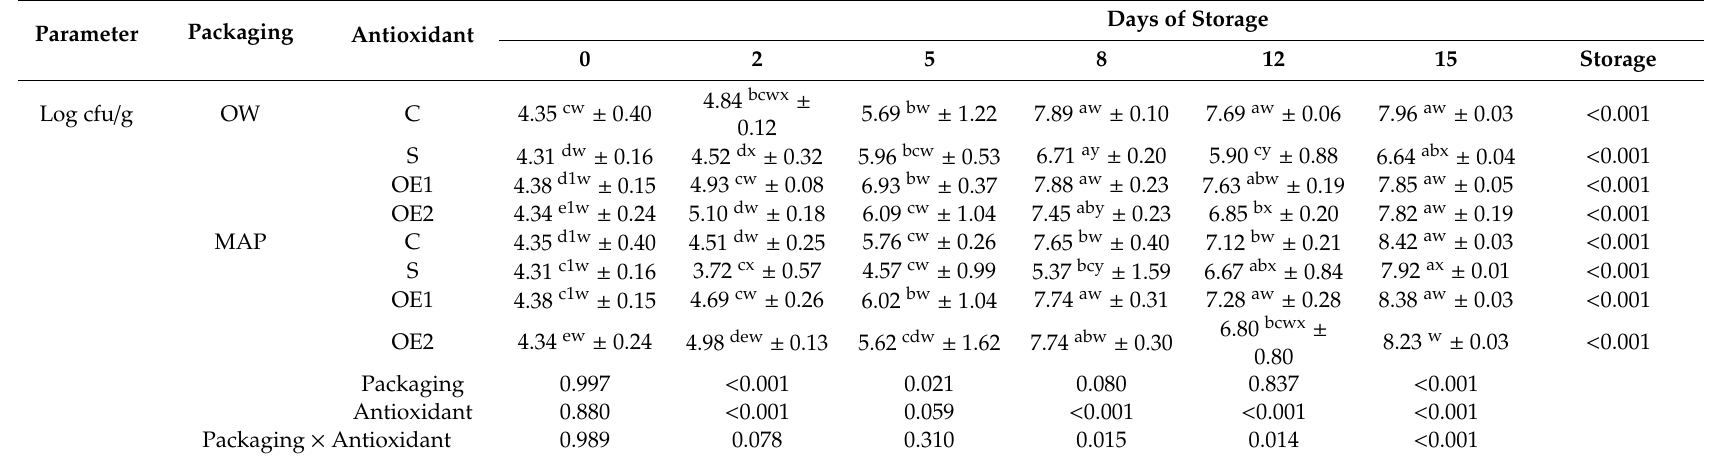
Table 6. Evolution of the total viable count (mean values ± standard deviations) of beef patties with di ff erent formulations α packed under di ff erent conditions β during storage at 4 ◦ C.